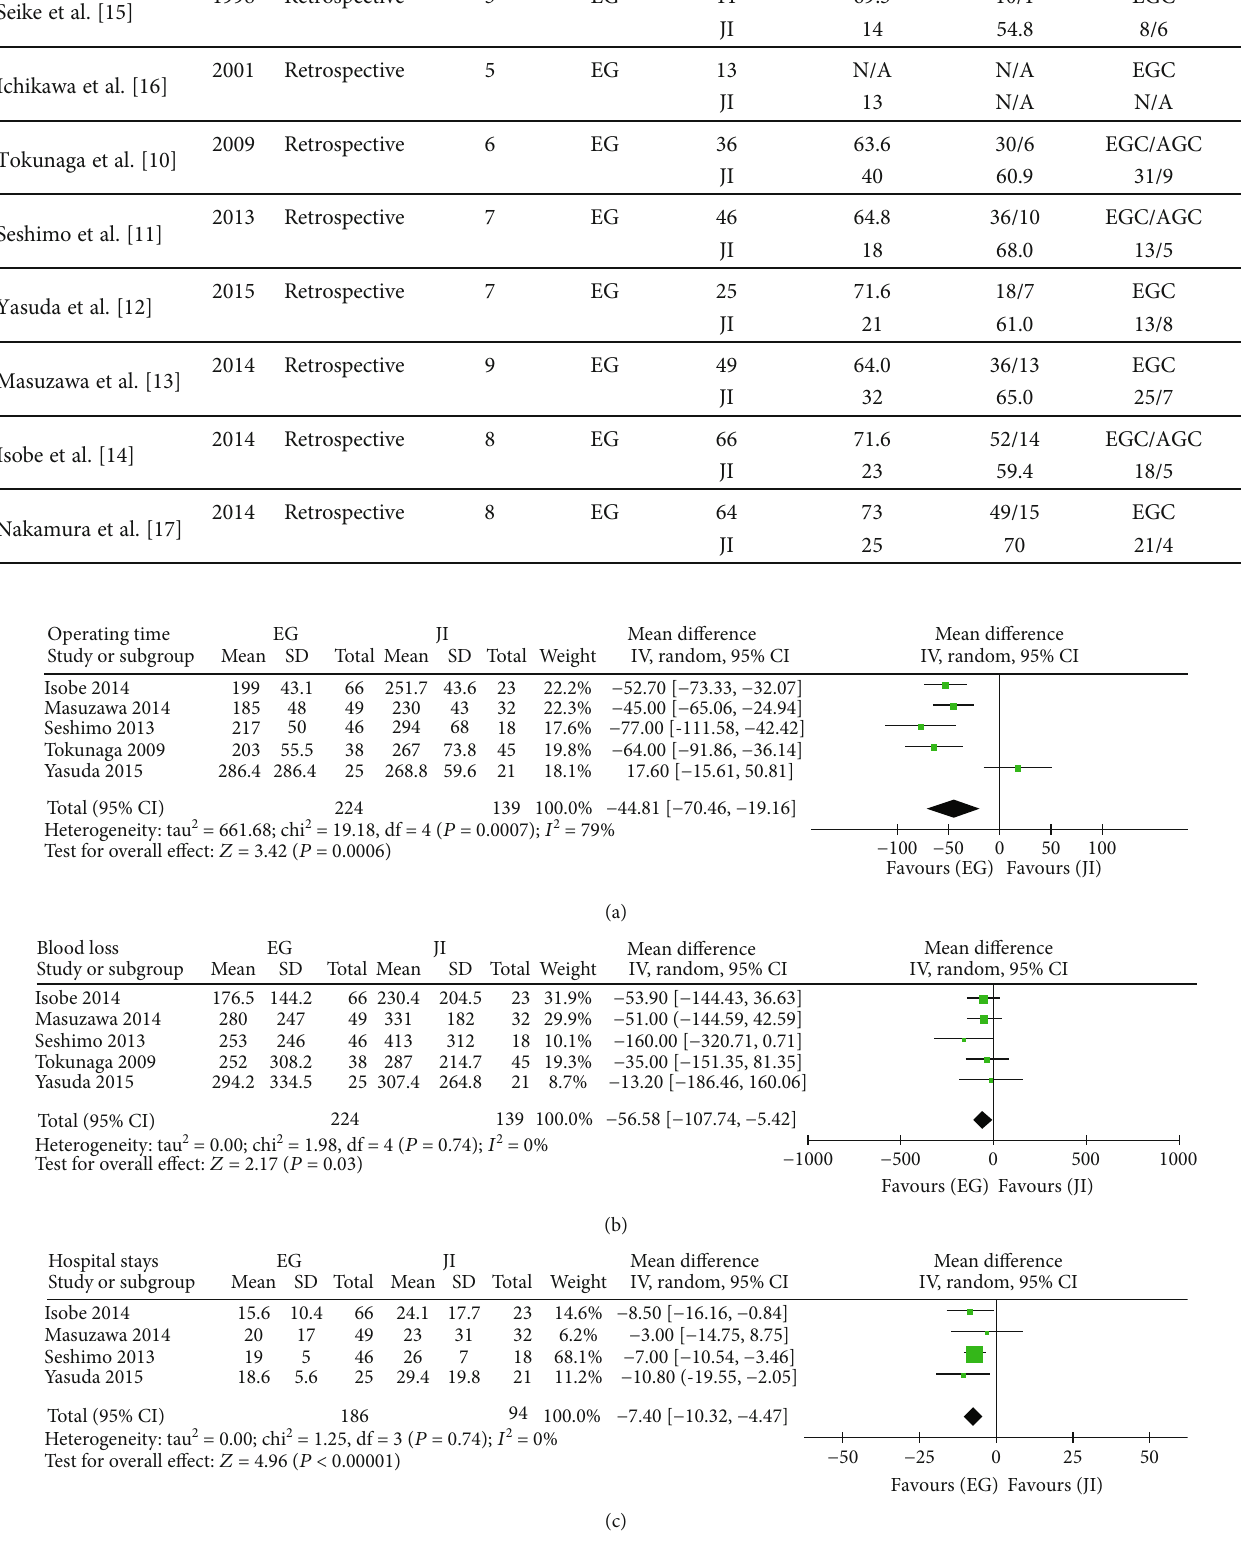
Figure 2: Meta-analysis of operative data on EG versus JI: (a) operative time (min), (b) blood loss (mL), and (c) postoperative hospital stays